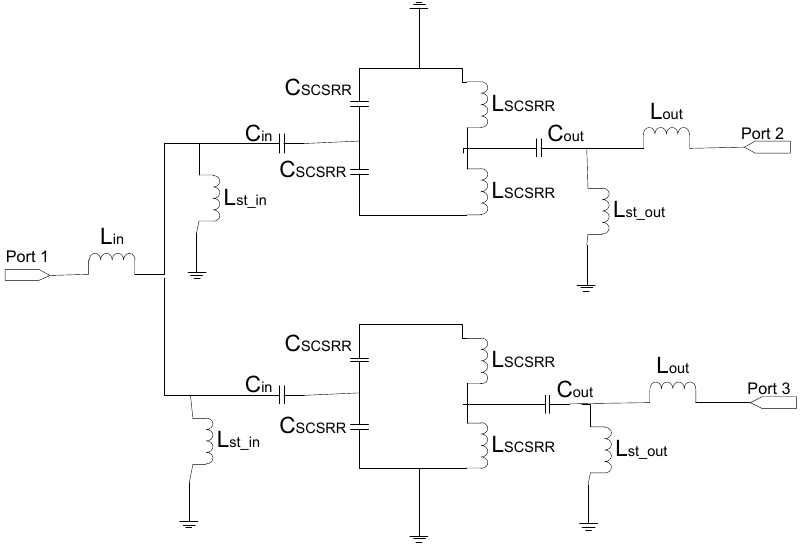
Figure 9. Equivalent circuit for the multi-layer power divider.